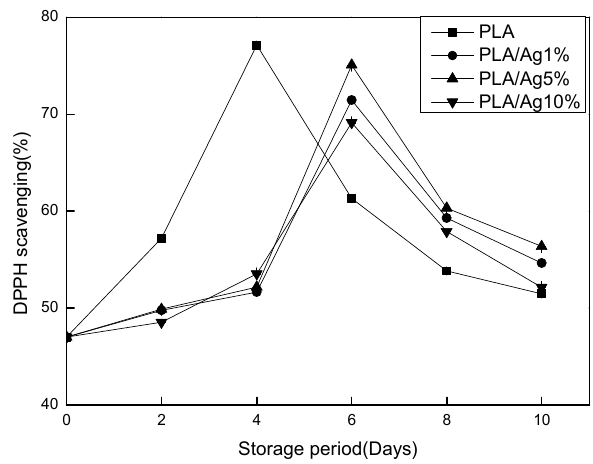
Figure 9. Effect of different concentration of nano-Ag active packages on antioxidant capacity measured by DPPH. Data are presented as mean ± standard deviation.